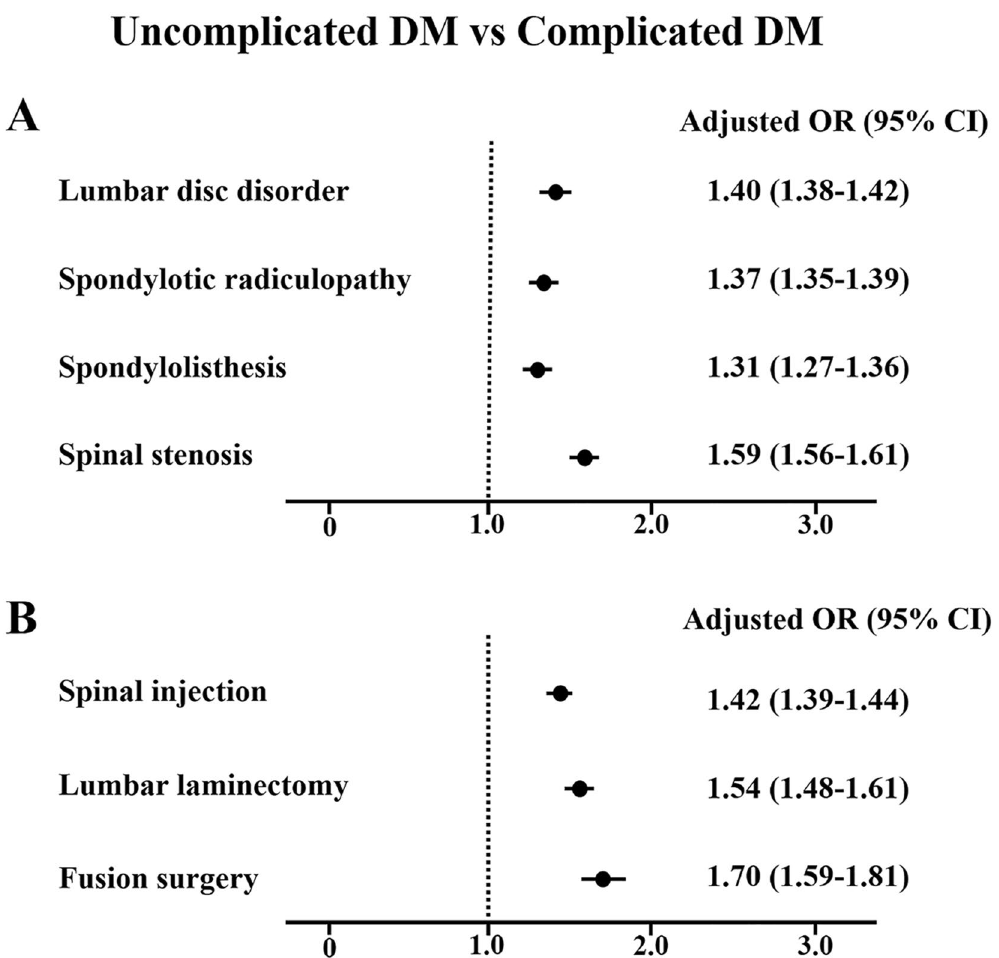
Figure 4. Association of complicated diabetes with ( A ) lumbar spine disorders and ( B ) spinal procedures compared with uncomplicated diabetes. Adjusted OR (95% CI) was estimated by multiple logistic regression analysis with adjustments for hypertension, chronic kidney disease, dyslipidemia, and the type of beneficiary. DM, diabetes mellitus; OR, odds ratio; CI, confidence